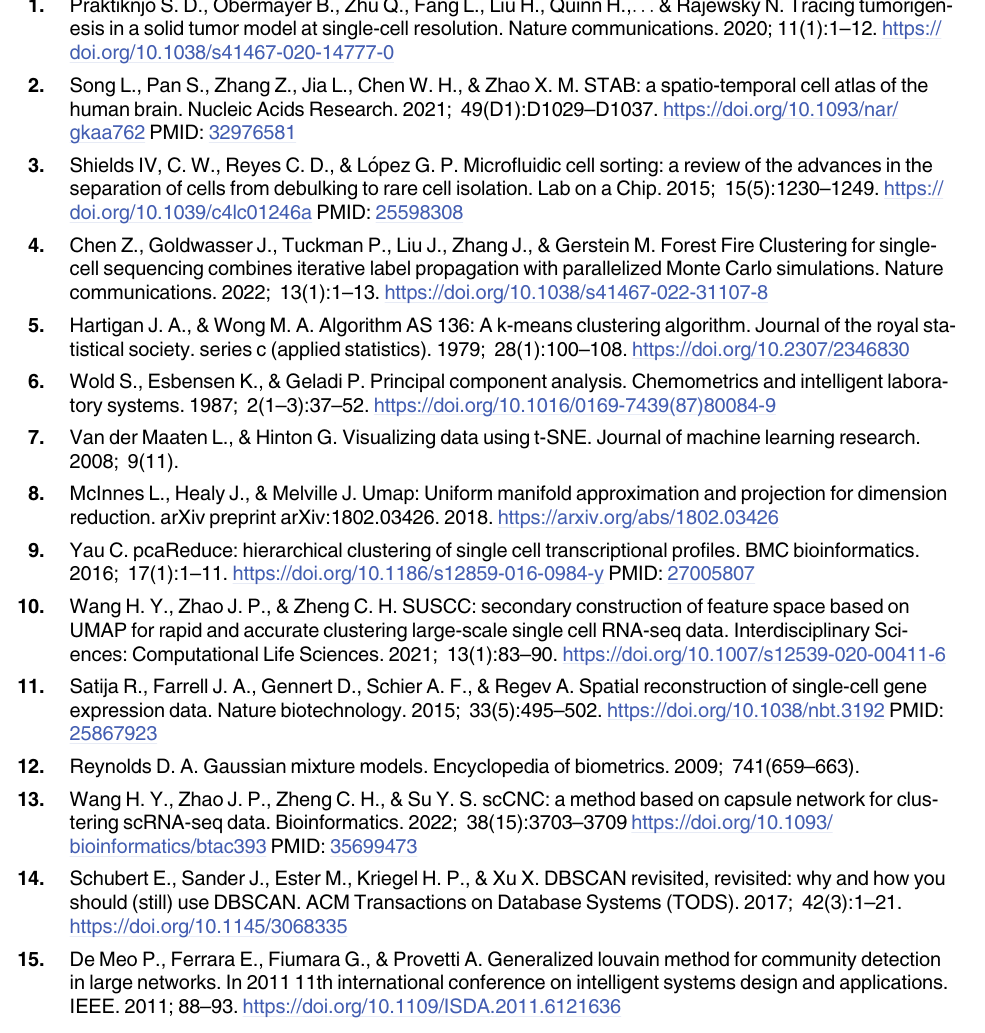
S6 Table. Comparison of the clustering performance of SC3 and scDSSC on 14